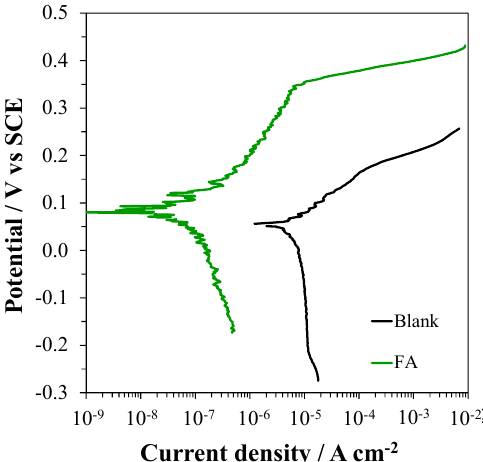
Figure 14. Polarization curves recorded on bare bronze after 20 days of immersion in AR × 10, in the absence (Blank) and in the presence (FA) of suspended FA particles.